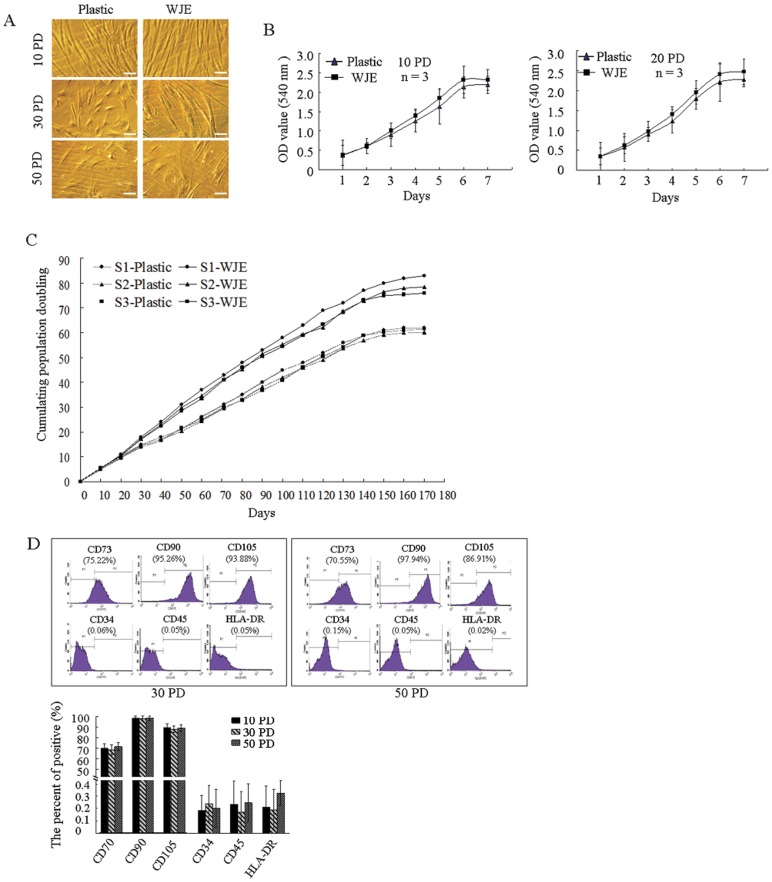
Characteristics of long-term cultured UC-MSCs on WJE-coated plates.(A) Morphological changes of long-term cultured UC-MSCs on WJE-coated plates by microscopy. Scale bars, 20 µm. (B) Proliferation ability of UC-MSCs cultured on WJE-coated plates by MTT assay. (C) Growth curve of long-term cultured UC-MSCs on WJE-coated plates. (D) Flow cytometric analysis of a representative example of UC-MSC (top). Histograms of a representative UC-MSCs culture on WJE-coated plate stained for lineage negative, and positive cell surface markers. Data are mean ± SD (n = 3) (*P>0.05).